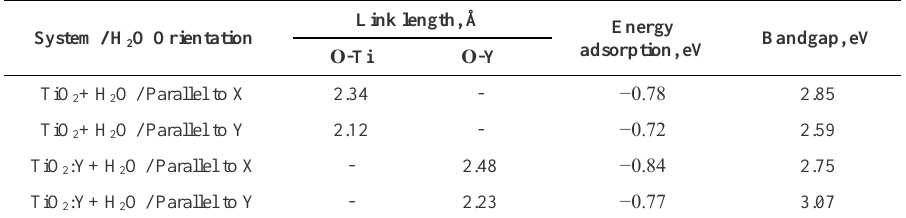
Table 1. Energy adsorption of H 2 O - molecules on the TiO 2